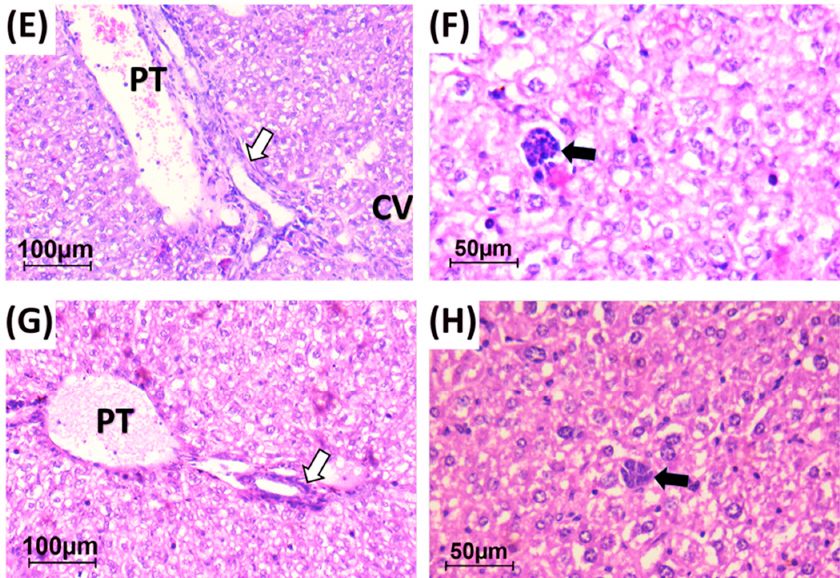
Figure 7. Histologic findings in H&E-stained liver sections in the studied groups: Saline: ( A ) Liver tissue showing mild distortion of lobular architecture. Portal tract (PT) exhibiting severe congestion of portal vessels and severe inflammation. Central veins (CV) are congested as well. Multiple large necroinflammatory foci (black arrows) were detected ( × 200). ( B ) High power view of one portal tract showing portal inflammation with interface hepatitis (white arrow) ( × 400). NAL: ( C ) Portal tract (PT) showing severe congestion of portal vessels and moderate inflammation (white arrow) ( × 200). ( D ) High power view showing multiple small necroinflammatory foci (black arrow) in liver lobule with diffuse degenerative changes of hepatocytes ( × 400). HasAp: ( E ) Portal tract (PT) showing severe congestion of portal vessels and still noted moderate inflammation (white arrow) ( × 200). ( F ) High power view showing small necroinflammatory foci (black arrow) among degenerated hepatocytes ( × 400). HasAp+NAL: ( G ) Portal tract (PT) showing minimal inflammation and moderate congestion of portal vessels (white arrow) ( × 200). ( H ) High power view showing small infrequent necroinflammatory foci (black arrow) and only focal degenerative changes in hepatocytes ( × 400). PT: portal tract. CV: central vein. Black arrow: necrotic focus. White arrow: portal